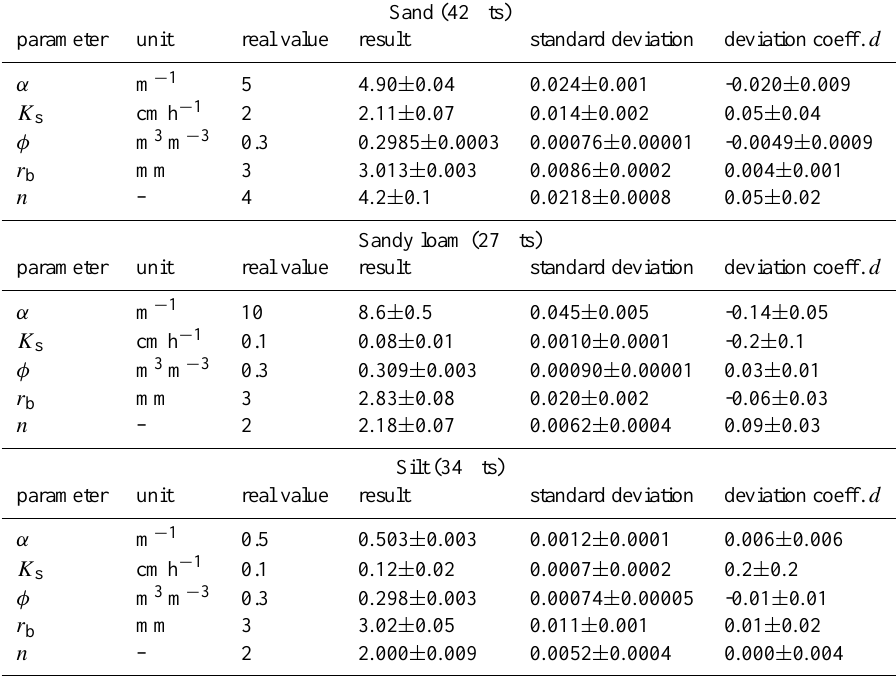
Table 4. Results of the convergence study with j w and ψ m as target variables. For the resulting parameters and standard deviations from the model output, as well as the deviation coefficients d defined by Eq. (12), mean and variance of the inversion of the start parameter sets with each of the data sets are